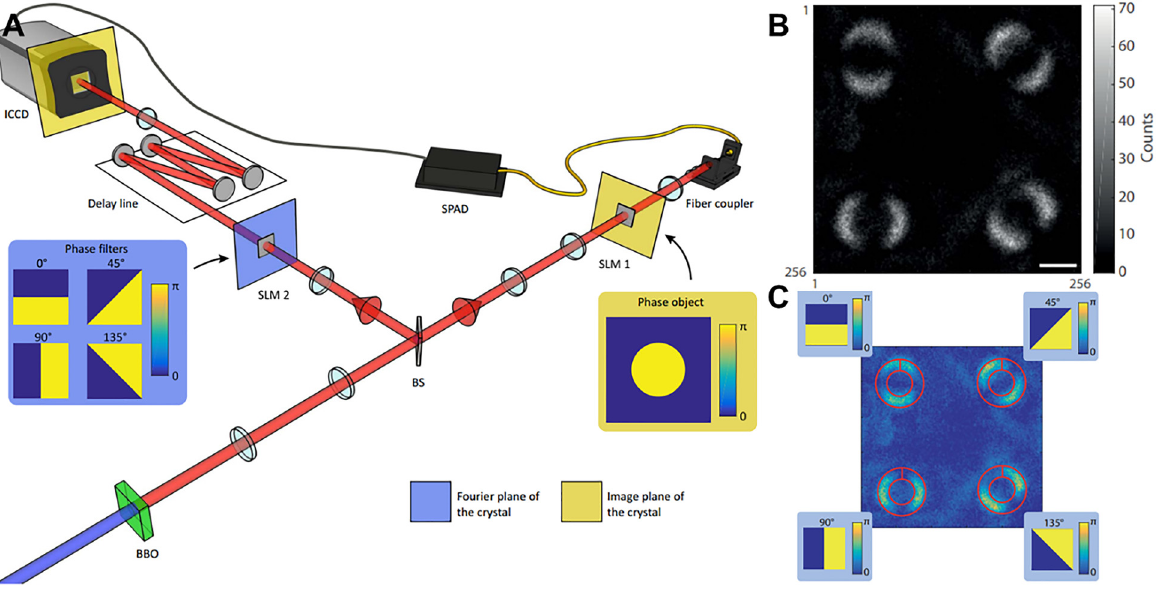
Figure 8: Edge-enhanced image based on quantum imaging violates Bell inequality [42]. (A) Perform imaging settings for Bell inequality test. A β -barium borate (BBO) crystal pumped by an ultraviolet laser serves as a source of entangled photons. The beam splitter (BS) separates pairs of entangled photons. The intensi fi ed charge coupled device (ICCD) camera acquires the ghost image of the phase object in spatial light modulator (SLM 1) placed on the fi rst photon path. Four different spatial fi lters implement nonlocal fi ltering. These spatial fi lters and the camera are placed in another optical path. By being triggered by single-photon avalanche diode (SPAD), the camera acquires a coincident image that can be used to perform the Bell test. (B) The coincidence of the same phasecircleobtainedbyusingfourphase fi ltersindifferentdirectionscountsasingleimage.(C)Thecorrespondencebetweenthephase fi lter usedandthespeci fi cobservationoftheobjectacquiredinasingleimageishighlighted,byaring-likeregionofinterest(ROI)alongtheedgeof the phase circle object within